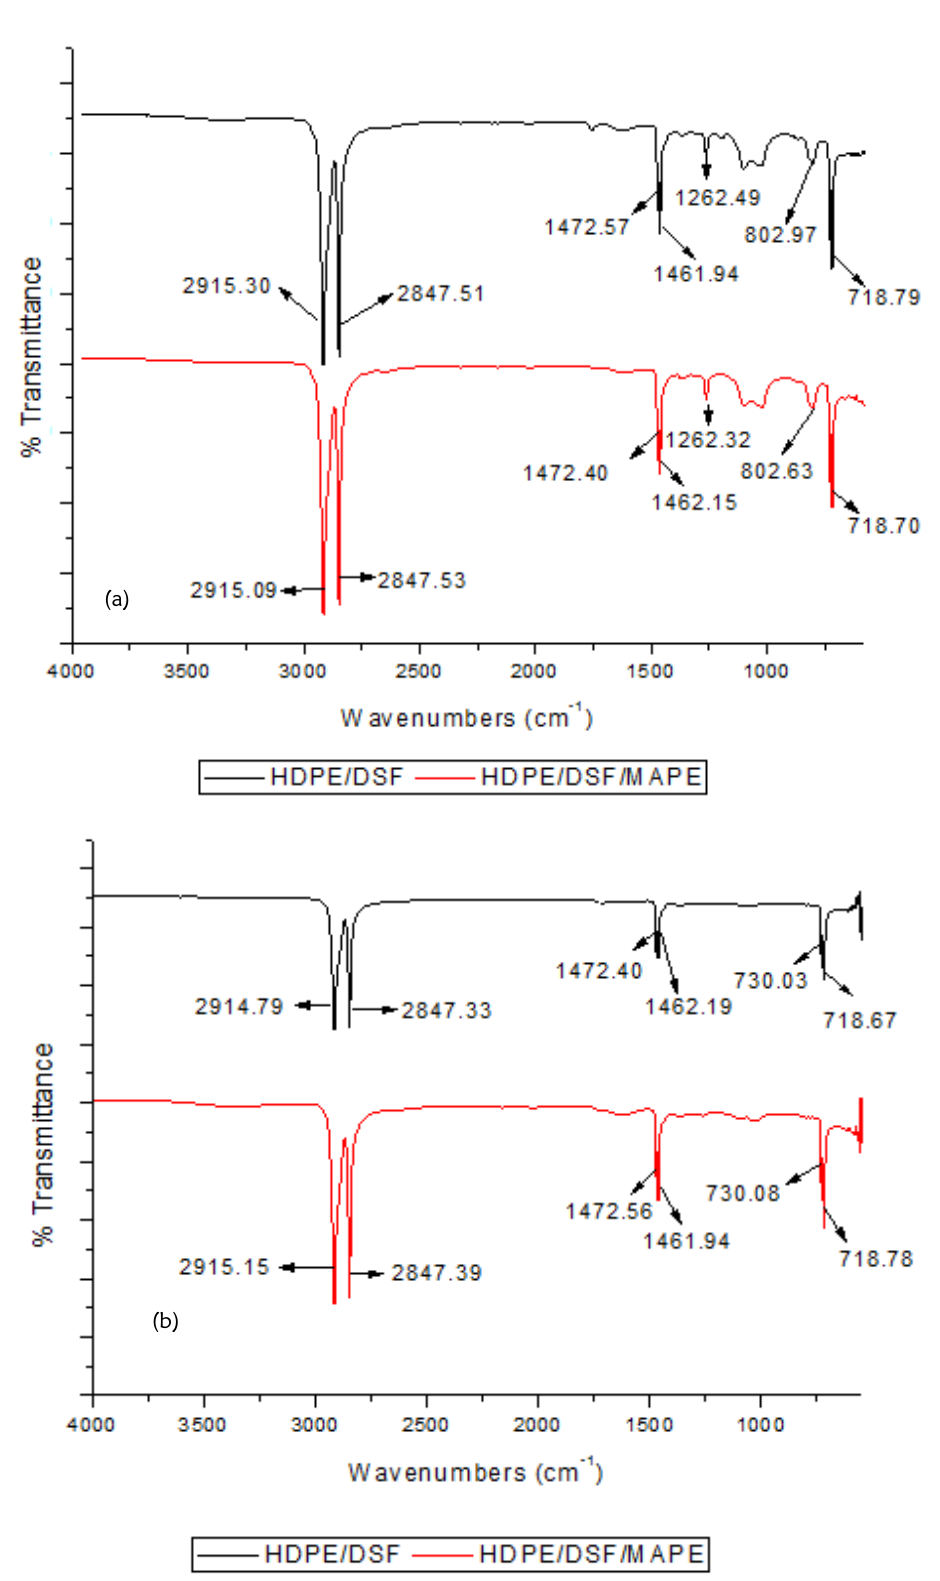
Figure 5: IR spectra of HDPE/DSF composite and HDPE/DSF/MAPE composite (a) unexposed UV (b) exposed